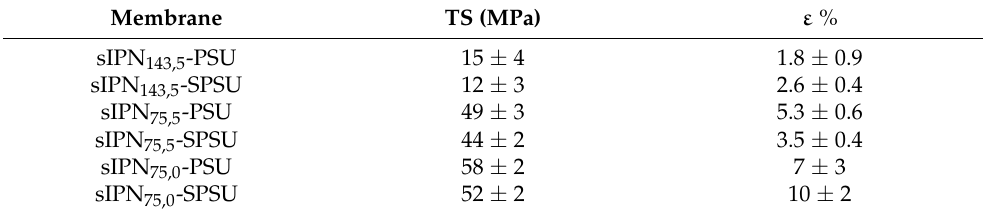
Figure 5. Stress-Strain curves of sIPN 75,0 -PSU (—–) and sIPN 75,0 -SPSU ( ····· ) in the external chart and sIPN 75,5 -SPSU (- · - · - · -) and sIPN 143,5 -SPSU (- ·· - ·· -) in the internal chart. Table 1. Tensile strength and elongation at break ( ε ) determined from the stress-strain curves of the membranes in the Cl − form. Standard deviation is also